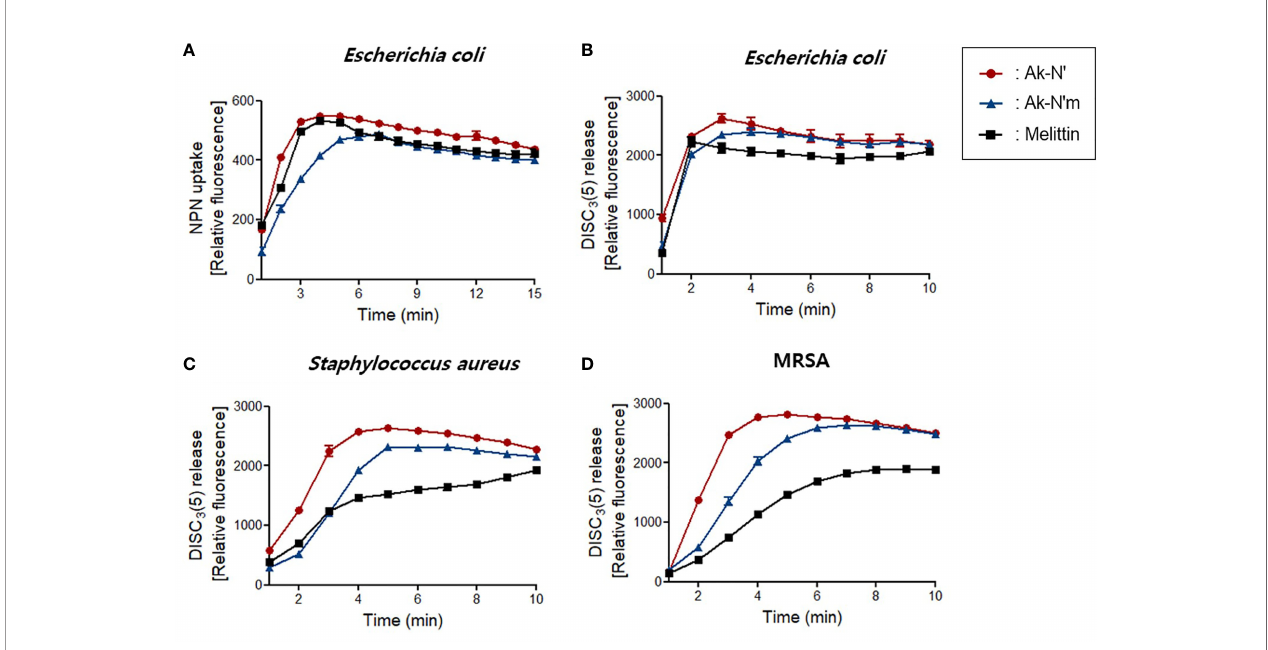
FIGURE 3 | Bacterial membrane permeation by Ak-N ’ and Ak-N ’ m. (A) NPN uptake showed disruption of the outer membrane by 1 × MIC of Ak-N ’ and Ak-N ’ m on E . coli . (B-D) Depolarization of bacterial cytoplasmic membrane was measured using DISC 3 (5) dye. The peptides induced rapid increase of fl uorescence in E. coli , S. aureus , and MRSA within 5 min, showing comparable or stronger disruption of the bacterial membrane than